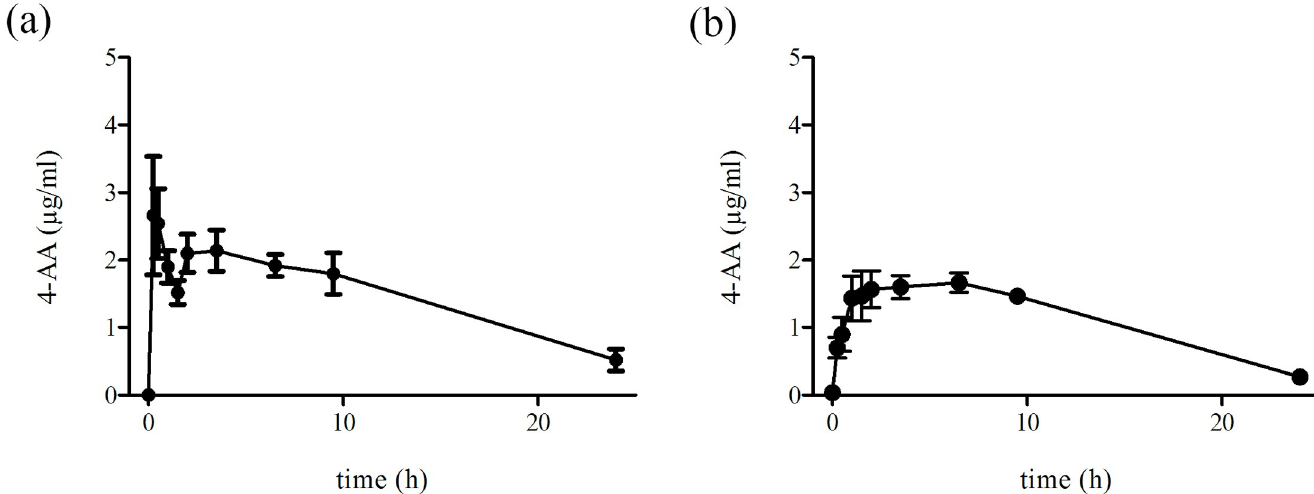
Fig 2. a. Plasma concentration over time of 4-AA after intravenous administration of 40 mg/kg metamizole in “fast metabolizing” calves subjected to ketamine/ xylazine/isoflurane anesthesia. Values are the mean ± S.D. from n = 5 calves. b. Plasma concentration over time of 4-AA after intravenous administration of 40 mg/kg metamizole in “slow metabolizing” calves subjected to ketamine/xylazine/isoflurane anesthesia. Values are the mean ± S.D. from n = 3 calves.